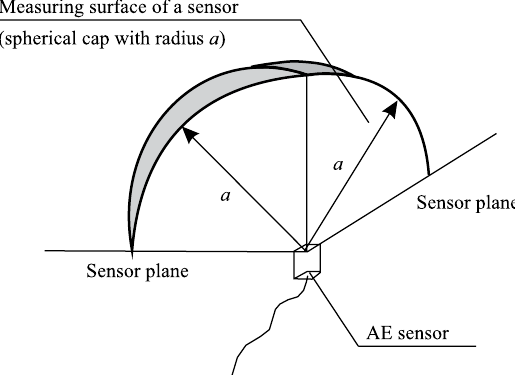
Fig. 2. Sensor measuring